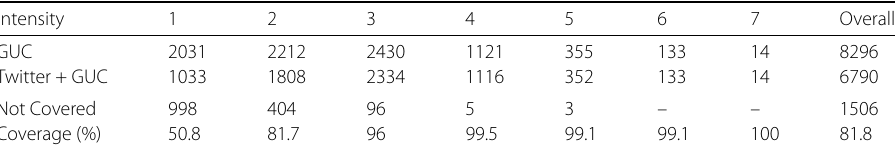
Table 2 Our dataset in terms of municipality-level local instances and the coverage of Twitter over the GUC